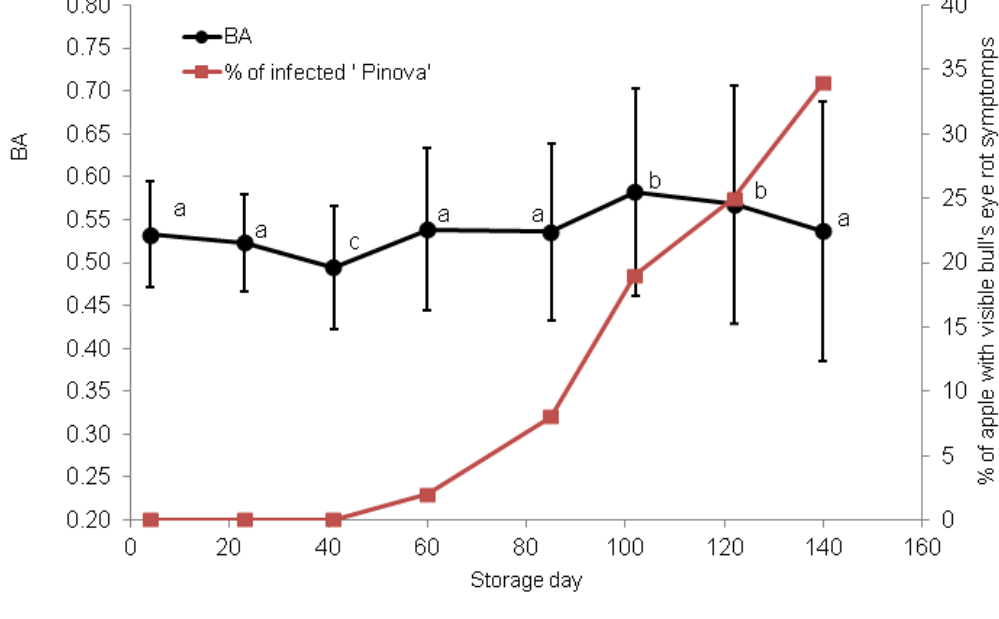
Figure 2. Biospeckle activity BA (black line) and percentage of infected fruit (red line) during development of bull’s eye rot of ‘Pinova’ apples. Bars indicate standard deviation; different letters denote significant differences (at α = 0.05) between